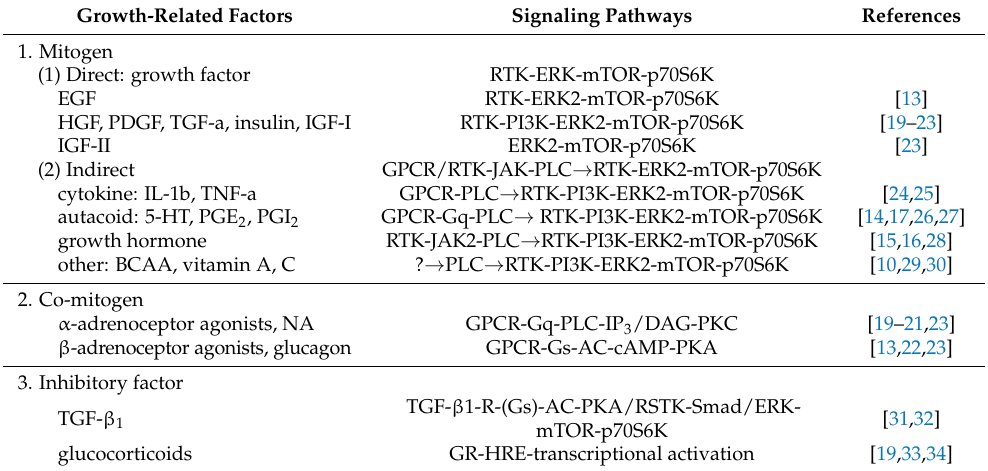
Table 1. Classification of hepatocyte growth regulators and their intracellular signaling